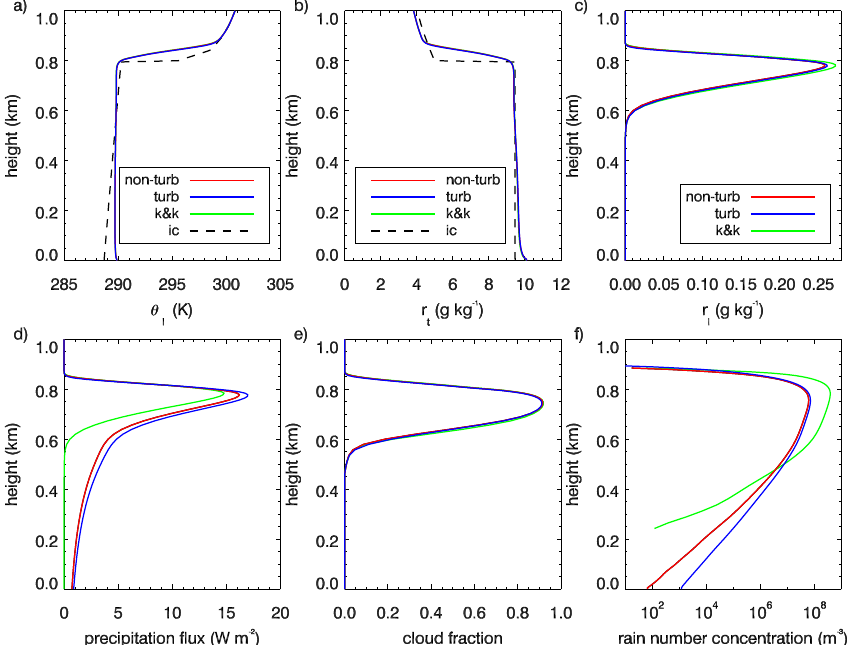
Figure 8. DYCOMS II cloud and dynamical properties for the simulations that use the turbulent (blue) and non-turbulent (red) microphysics parameterisations of Franklin (2008) and the microphysics scheme of Khairoutdinov and Kogan (2000; green). The initial conditions are represented by the black dashed line. (a) Liquid water potential temperature (K), (b) total water mixing ratio (gkg − 1 ) , (c) liquid water mixing ratio (gkg − 1 ) , (d) precipitation flux (Wm − 2 ) , (e) cloud fraction and (f) rain drop number concentration (m − 3 )